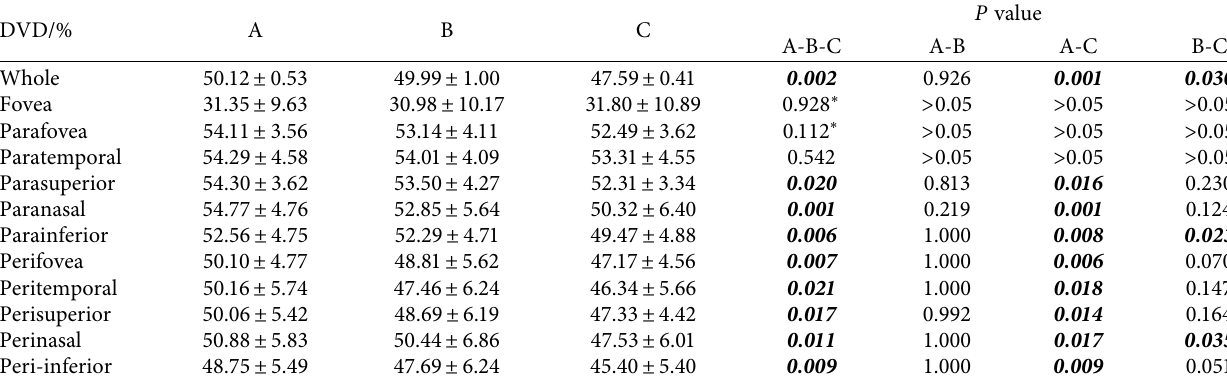
Table 3: DVD in the three diagnostic groups.